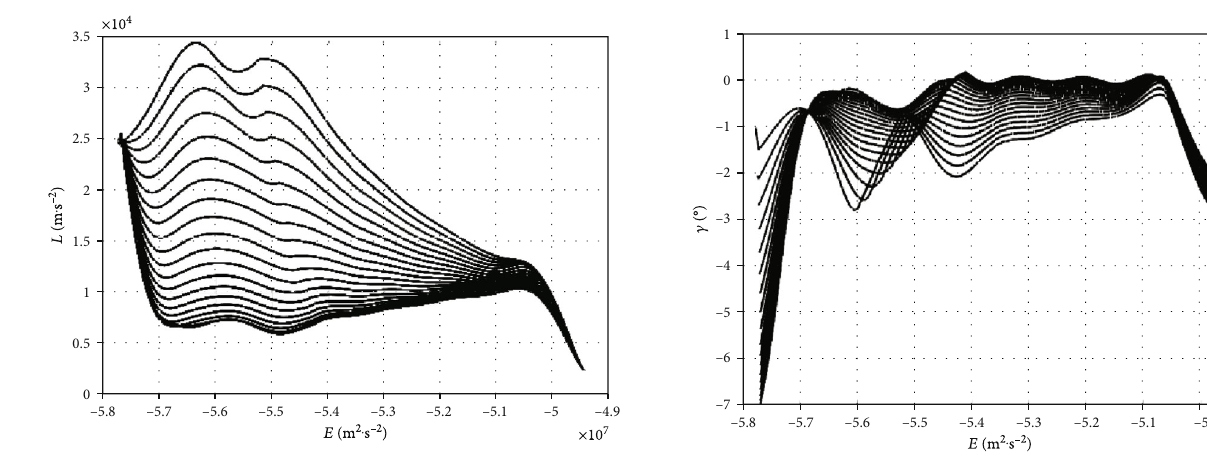
Figure 22: Flight path angle pro fi les for Case 1.